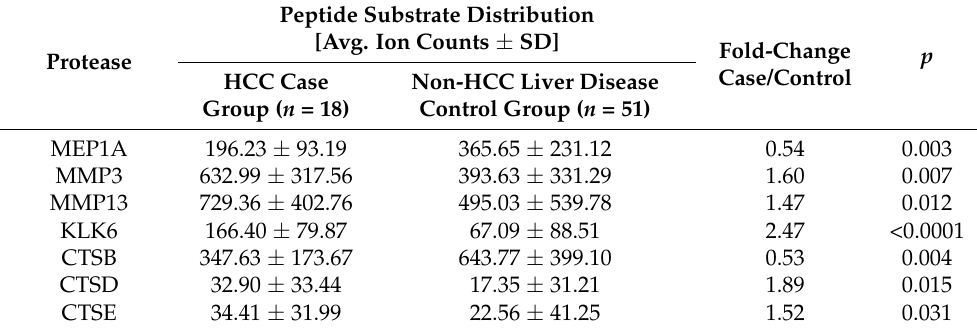
Table 4. Differences in the activities of the seven in silico predicted proteases meprin A subunit α (MEP1A), matrix metallopeptidase (MMP) 3 and 13, kallikrein-6 (KLK6) and cathepsin (CTS) B, D and E based on the fold change of the protease associated peptide substrate’s ion signals between the HCC case and non-HCC liver disease control groups. p -values were calculated by the Mann–Whitney U test. Peptide Substrate Distribution [Avg. Ion Counts ± SD] Fold-Change p Protease Case/Control HCC Case Non-HCC Liver Disease Group ( n = 18) Control Group ( n = 51)